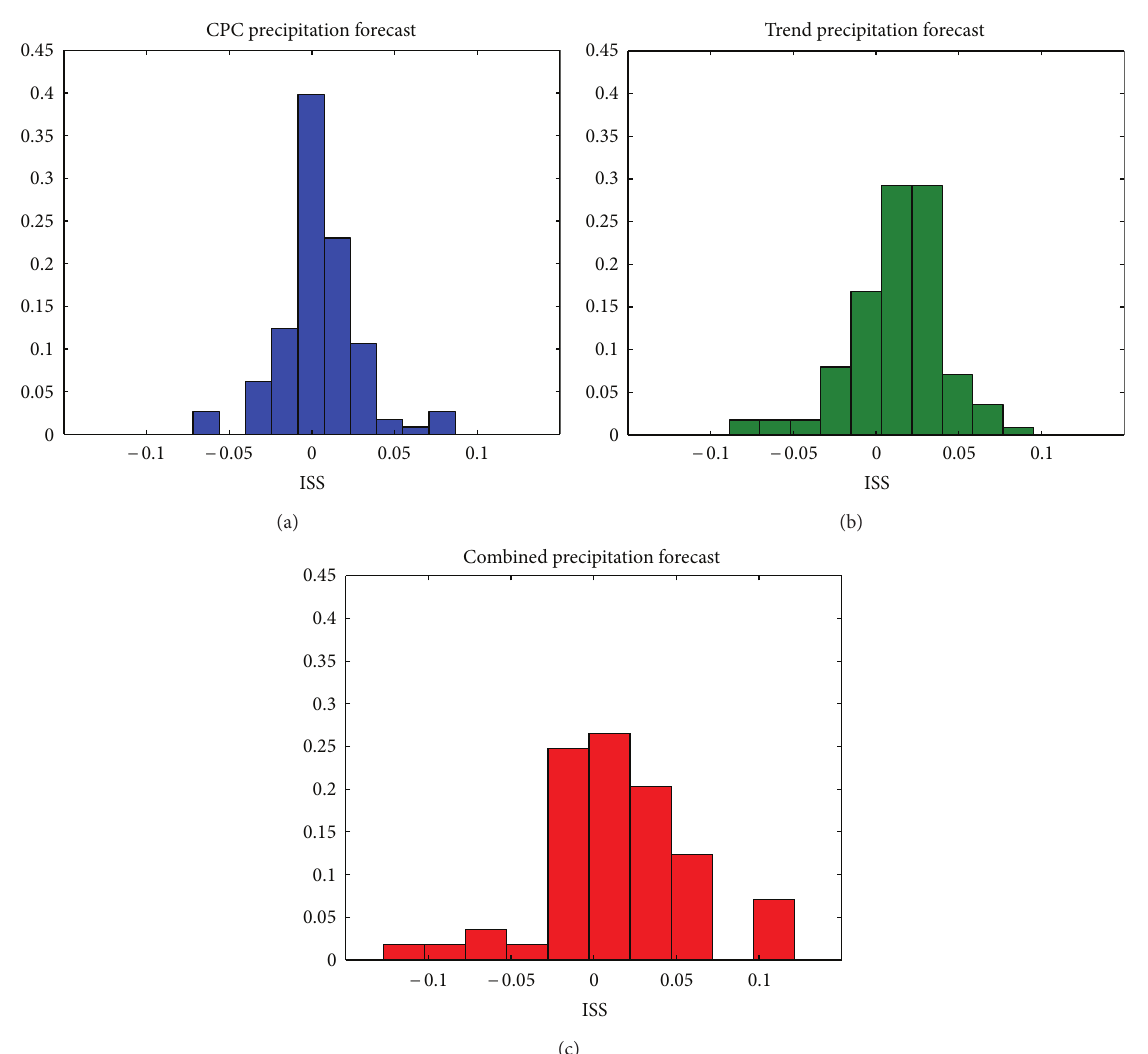
F 3: Same as Figure 2, but for precipitation